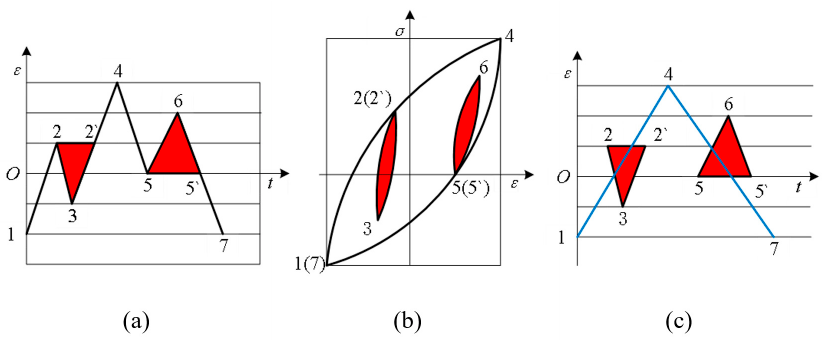
Figure 1. Principle of rain flow counting method (( a ) strain-time history, ( b ) stress-strain response, ( c ) cyclic extraction).